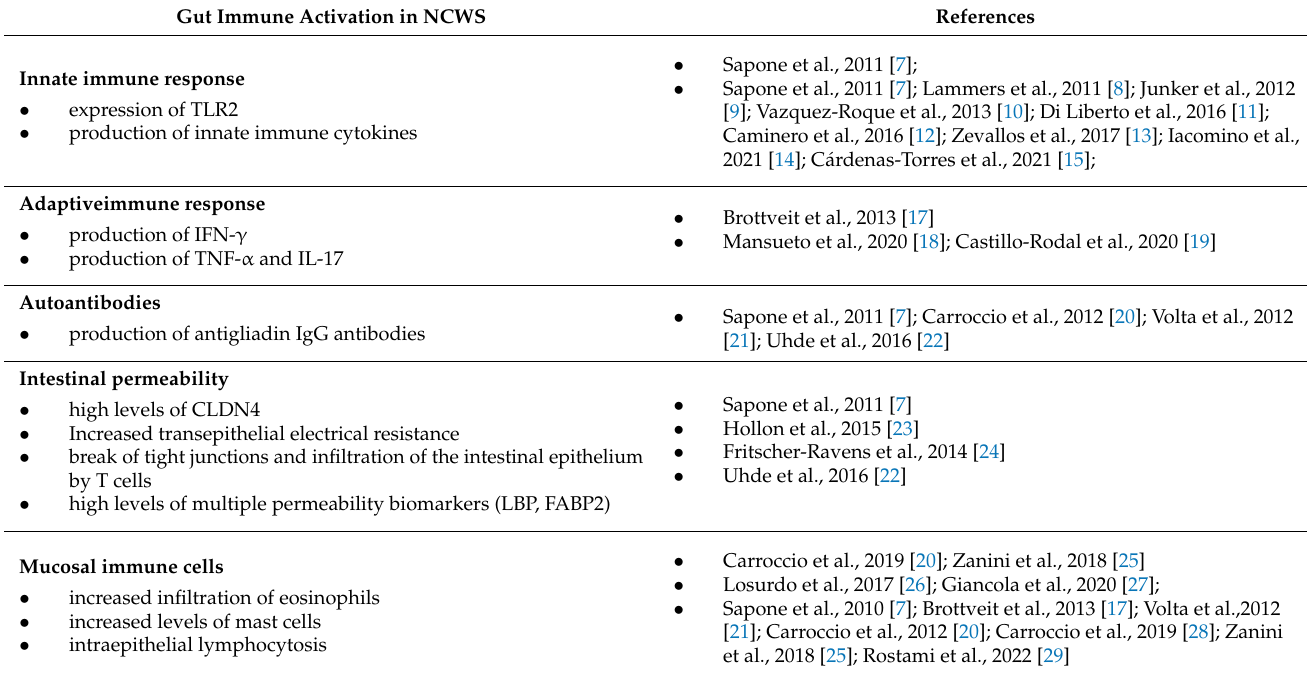
Table 1. Gut immune activation in